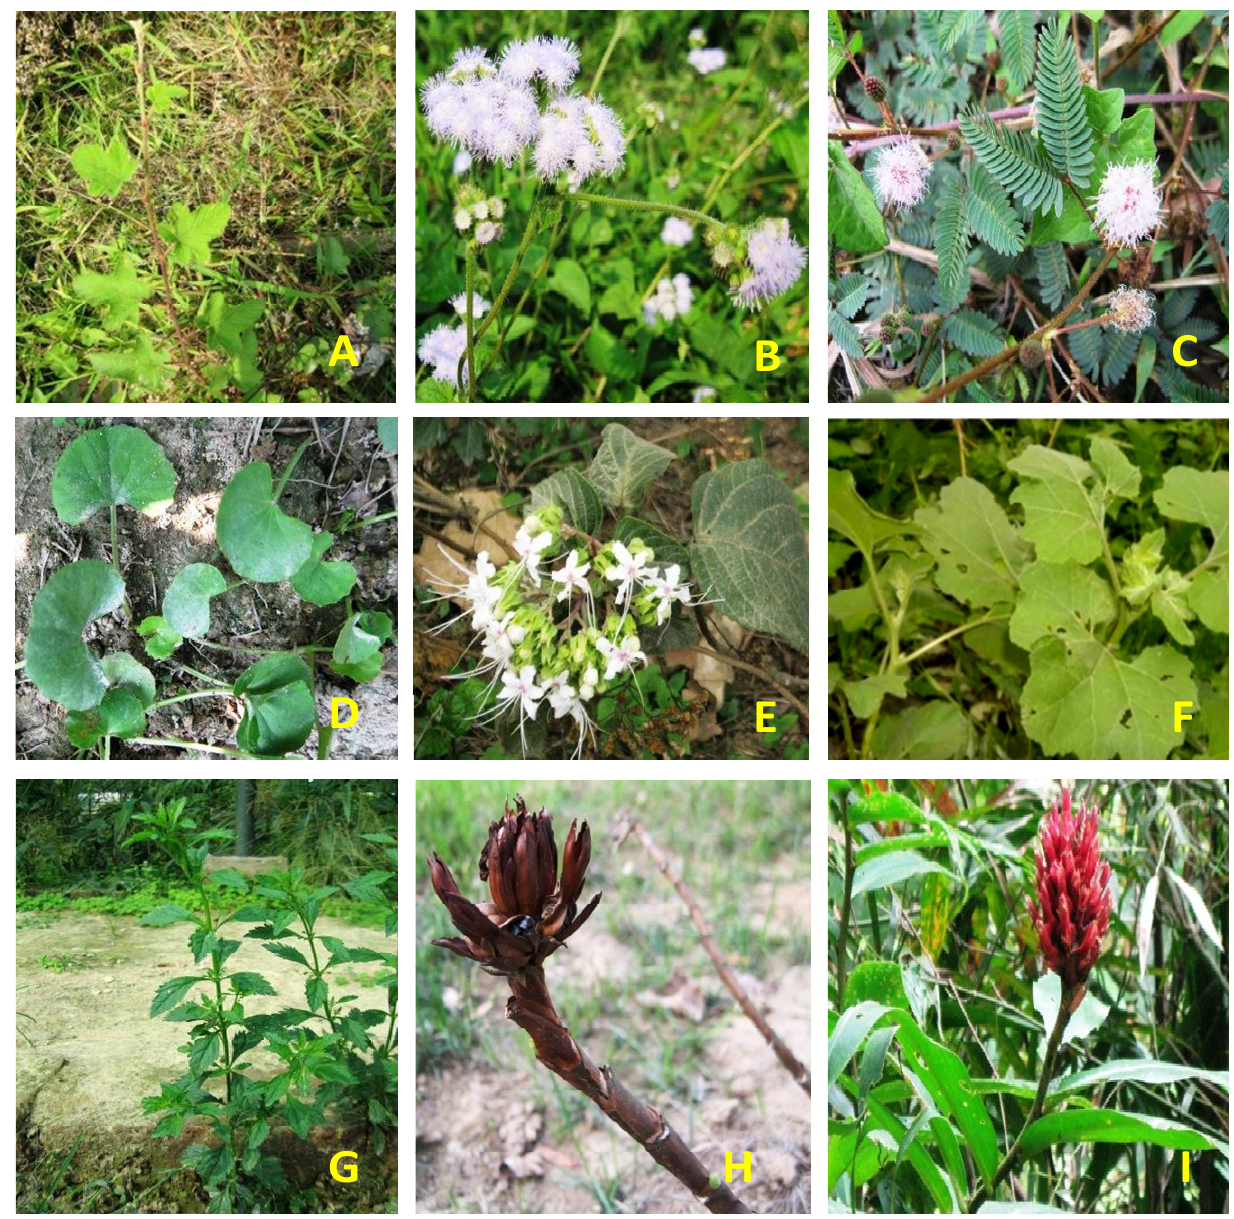
Fig. 5. Plants attributed ethnomedicinal claim by the Thengal- Kachari tribesmen; A – Rubus ellipticus ; B – Ageratum conyzoides , C – Mimosa pudica ; D – Centella asiatica ; E – Clerodendrum viscosum ; F – Xanthium strumarium ; G – Scoparia dulcis ; H – Costus speciosus ; I – Phlogacanthus